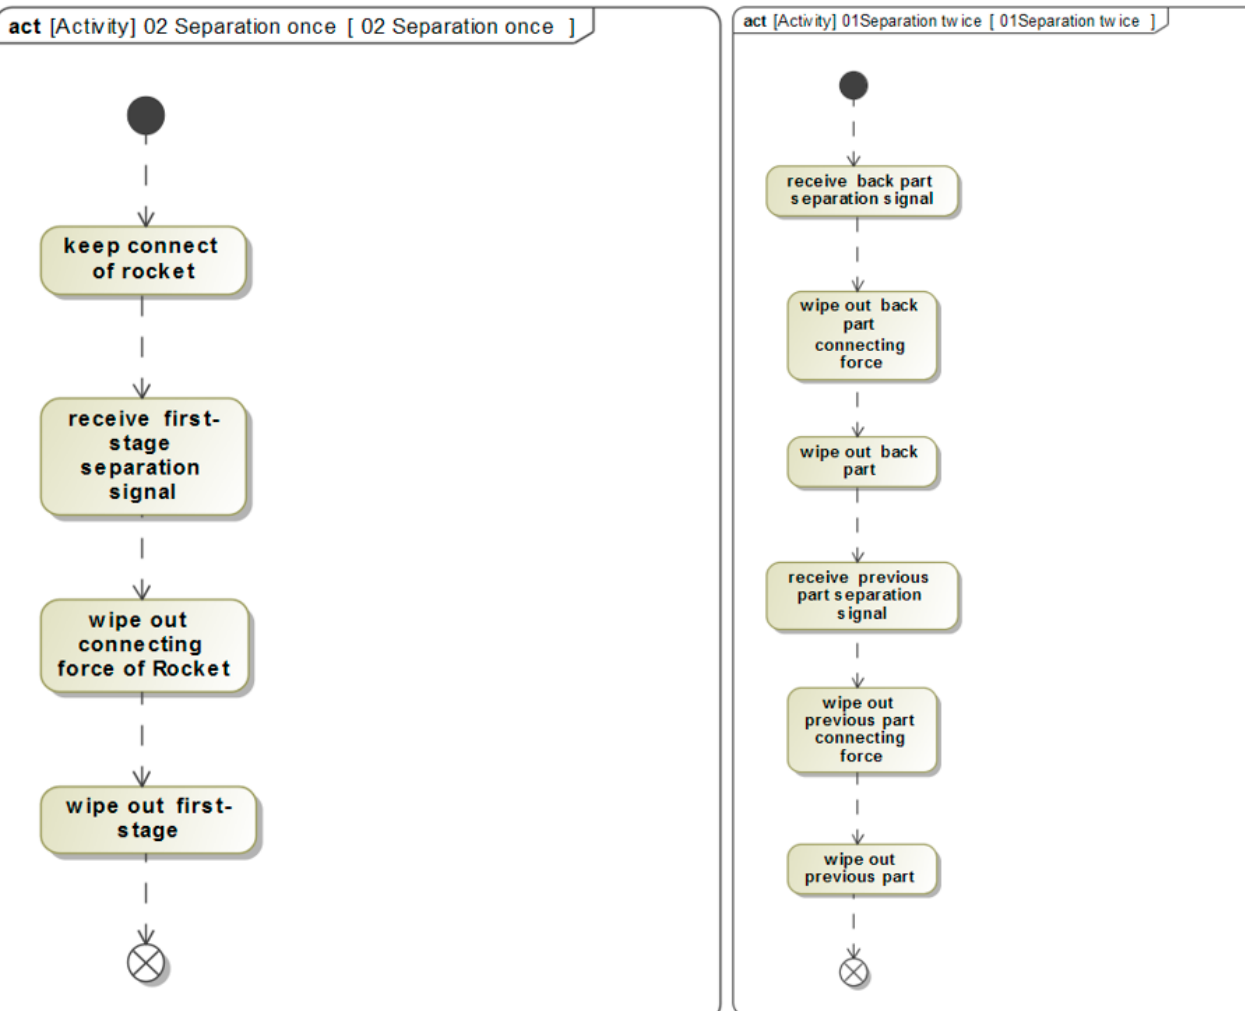
Figure 7. The tradeoffs result in functional architecture.